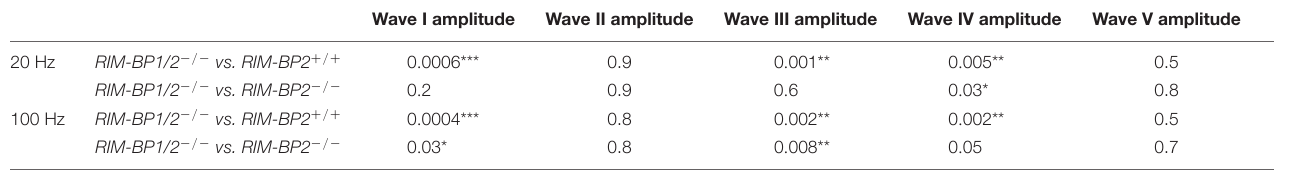
TABLE 4 | Summary of statistical analysis of ABR data. Wave I amplitude Wave II amplitude Wave III amplitude Wave IV amplitude Wave V